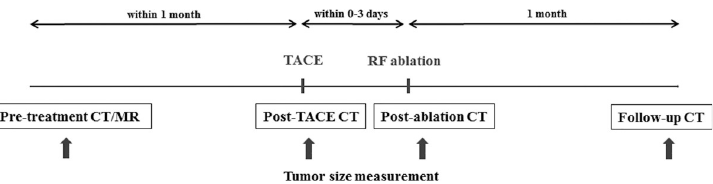
Fig 2. Study algorithm for patients with hepatocellular carcinoma. TACE= transcatheterarterialchemoembolization, RF =